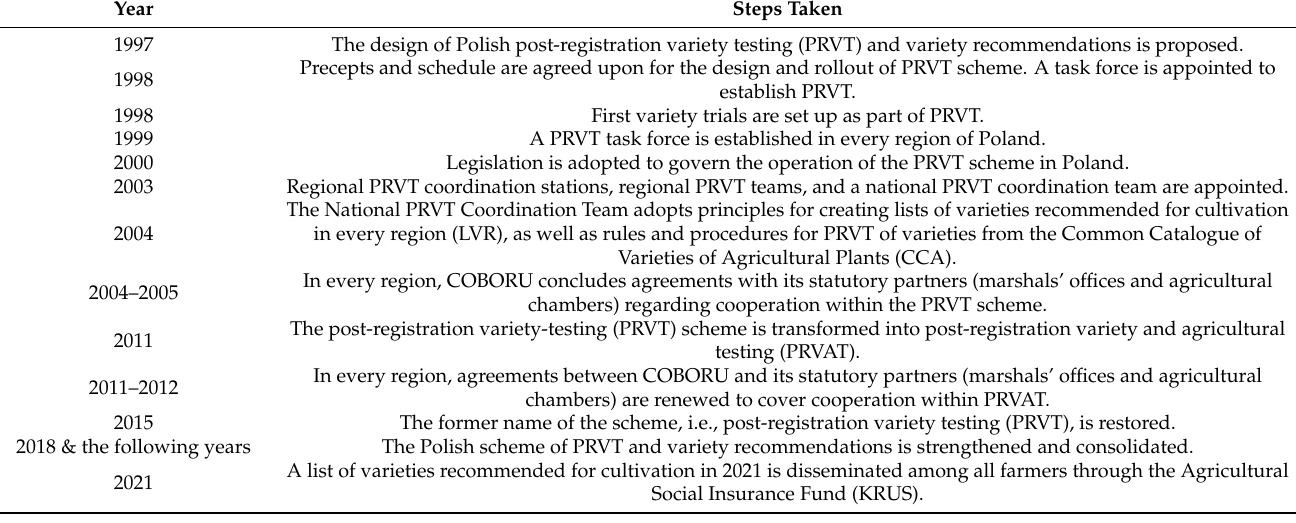
Table 1. Timeline of PRVT rollout and dissemination of results in